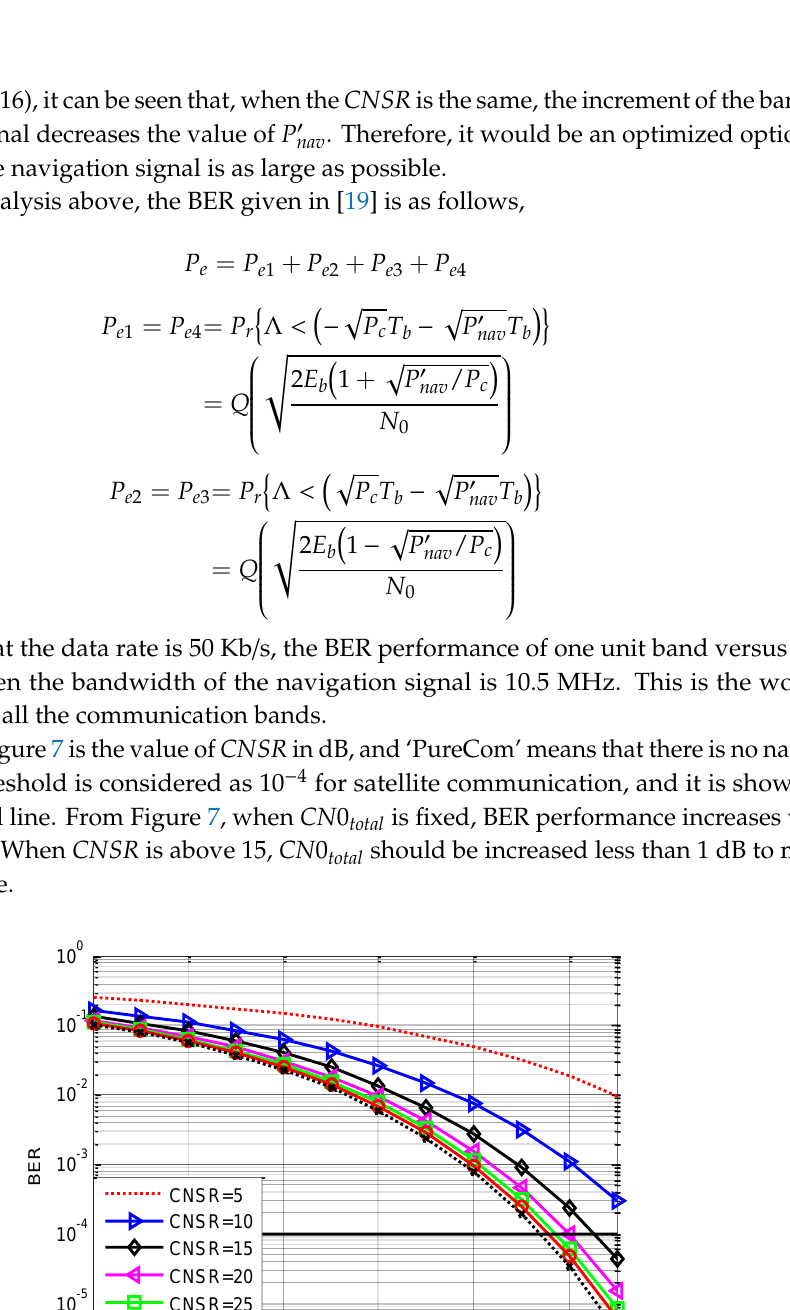
Figure 7. Bit error rate (BER) under versus 0